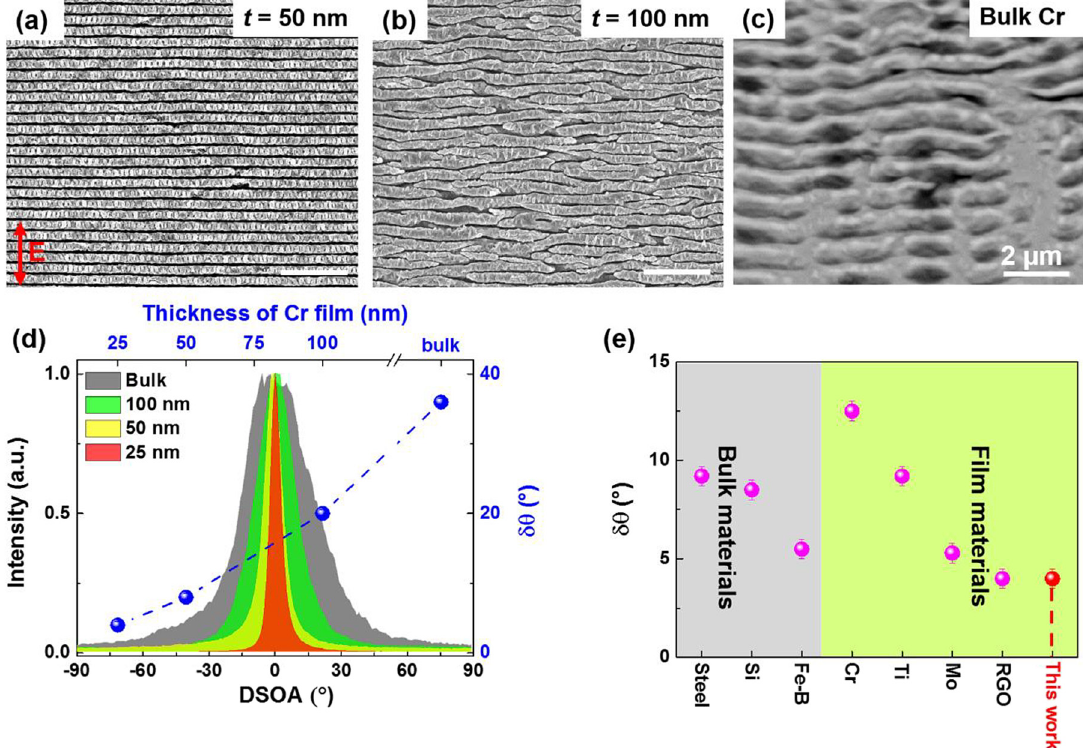
Figure 3: SEM images of the laser-induced surface structures on Cr films with different thicknesses. (a) t =50nm,(b) t =100nm,and(c)bulkdimension.(d)CalculatedDSOAcurvesandthecorrespondinghalf-maximum-full-width( δθ )valuesfor the surface structure formation on different fi lm thicknesses. (e) Summarization of the δθ values for the laser-induced structures reported in thepublishedpapersandformedonthe25nmthickCr/Sisampleinourwork.HereFe-BindicatesthematerialofFe-basedmetallicglass;RGO for the reduced graphene oxide fi